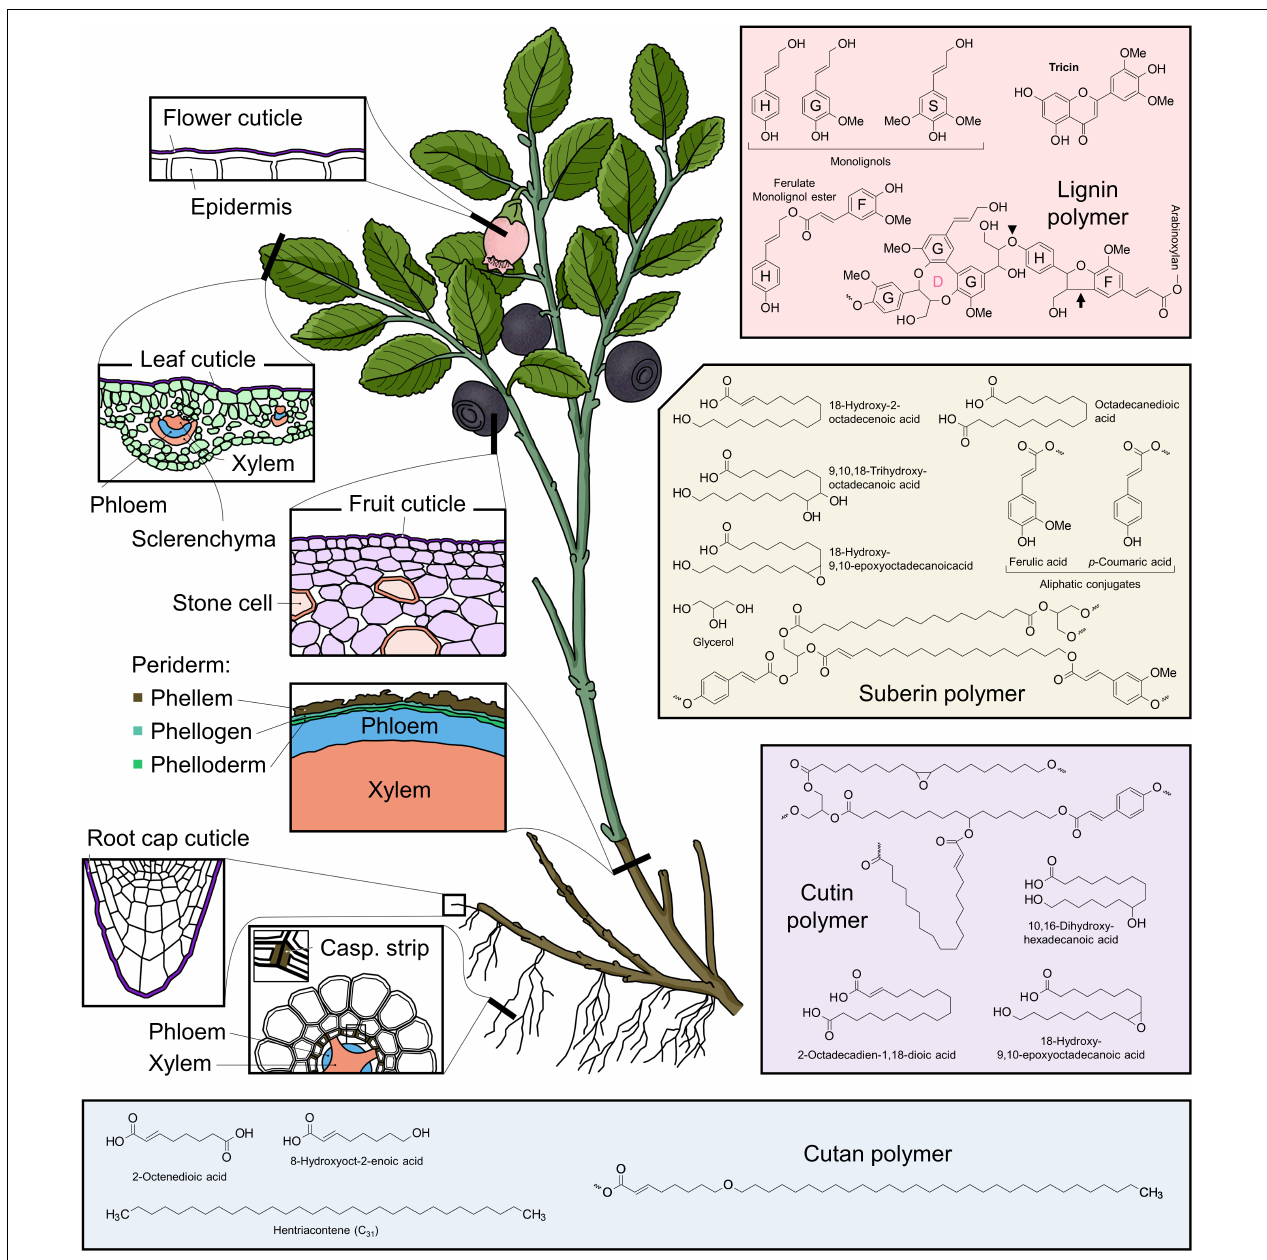
FIGURE 1 | Overview of the localizations of lignin, suberin, cutin, and cutan; their major precursors; and hypothetical polymer structures. Major organ- and tissue-specific localizations of the four hydrophobic biopolymers are as follows: lignin in vascular bundles of shoots and roots, in structural tissues, such as leaf sclerenchyma, and in idioblasts, such as fruit stone cells (Kumar et al., 2016); suberin in stem periderm and root endodermis (Casparian strip; Franke and Schreiber, 2007); cutin in the epidermal cuticle of leaves (Bourgault et al., 2020) and flowers (“nanobridges”; Li-Beisson et al., 2016) and in the root cap (Berhin et al., 2019); and cutan in the leaf and fruit cuticle of some species, such as Vaccinium myrtillus (Boom et al., 2005; Kallio et al., 2006). Examples of common constituents of the four biopolymers are as follows: lignin: three monolignols (H, G, and S), ferulate monolignol ester (similar to coumarate ester, not shown), and tricin represent lignin building blocks. A lignin polymer with ethers and C–C as the major bond types is represented here. The dibenzodioxocin (D) unit, an eight-membered ring, contains most of the 5–5 (C–C) bonds in lignin. The β -O-4 ether bond is prevalent in lignin, e.g., linking G and H monolignols (arrowhead). The β -5 (C–C) link is illustrated by H monolignol and ferulate (F) bonding (arrow) (Ralph et al., 2019). Lignin building blocks are polymerized in the apoplast by oxidative coupling reactions mediated by peroxidases and laccases (Tobimatsu and Schuetz, 2019). Additional hydroxy groups (–OH) from water are introduced to the α C of the side chains through quinone methide re-aromatization after the coupling reaction (Tobimatsu and Schuetz, 2019). The F, which is oxidatively coupled to, e.g., H residues, can cross-link lignin to neighboring arabinoxylans in the cell wall through an ester bond (Ralph et al., 2019). Wiggle lines indicate unspecified ether bonds. Suberin: the predominant aliphatic-domain of suberin is represented by C 18 fatty acids with mid-chain or ε -modifications (Franke et al., 2005; Pinto et al., 2009); ferulic acid and p -coumaric acid are the known aromatic constituents of suberin (Franke et al., 2005). Glycerol is a minor component (Franke and Schreiber, 2007) and might be ester-bonded